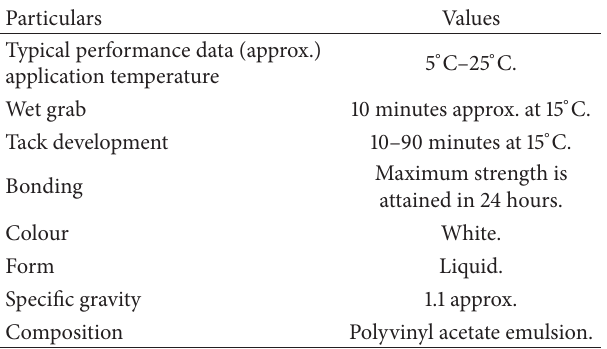
Table 4: Polyvinyl acetate properties.